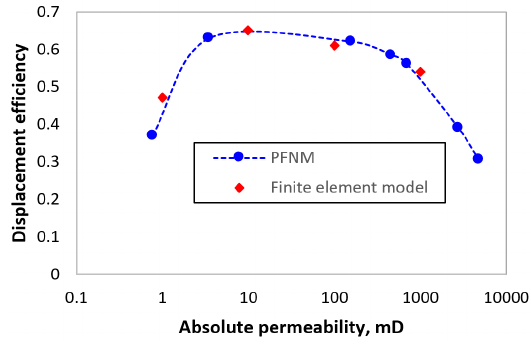
Figure 6. Comparison of displacement efficiency for the finite element model and PFNM.